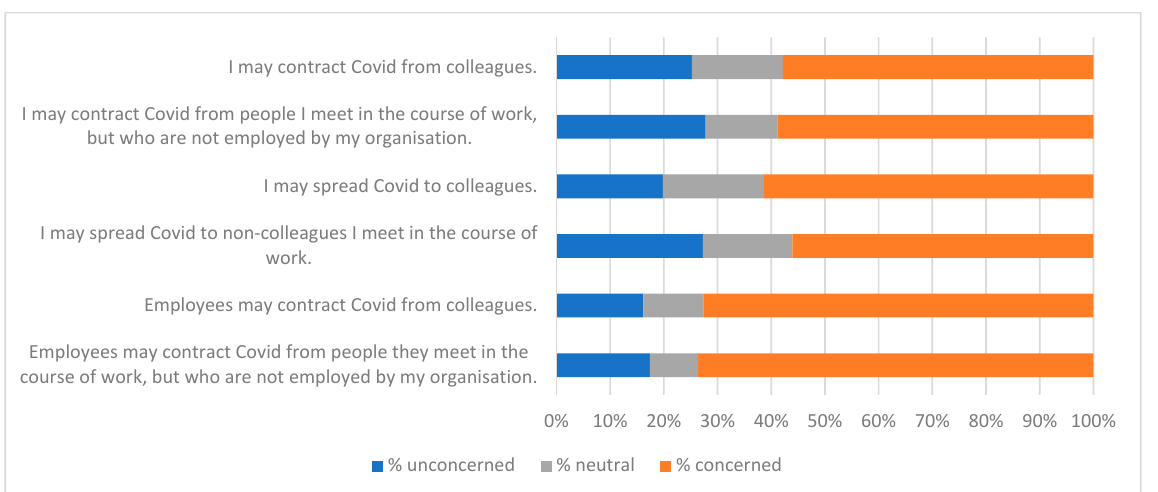
Figure 5. Spread of COVID-19.